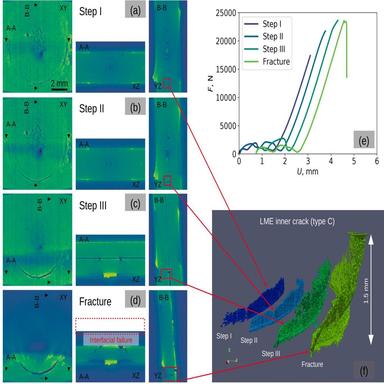
Loaded-crack sample. a-d) Slices in the tomography volumes at increasing load levels. e) Interrupted loading curves depicting the increasing load steps, where the curves are virtually shifted from each other for better readability. f) 3D rendering of the LME inner crack during loading. Final fracture occurs by full interfacial failure independently of the observed LME cracks.